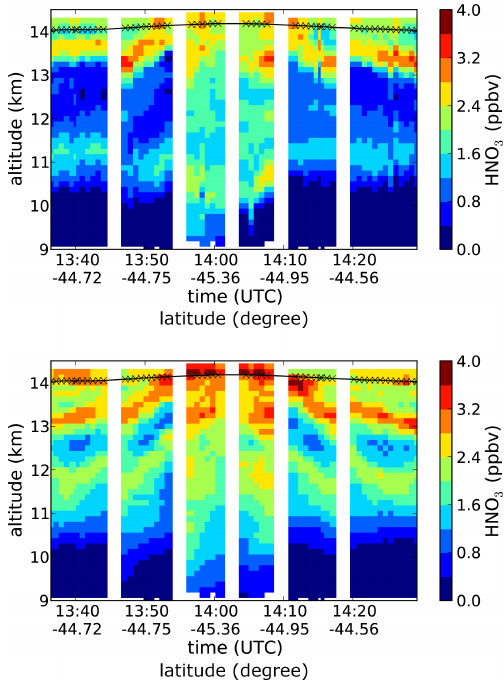
Figure 20. HNO 3 horizontal resolution at 20 ◦ E (top) and 13km altitude (bottom). For details see caption of Fig. 17. Figure 21. Comparison between a one-dimensional (top) and three- dimensional (bottom) reconstruction of HNO 3 during the GLORIA hexagonal flight. The segments of the hexagon are separated by white stripes. Measurement time (UTC) and latitude (degree) for the beginning of each segment are given on the x